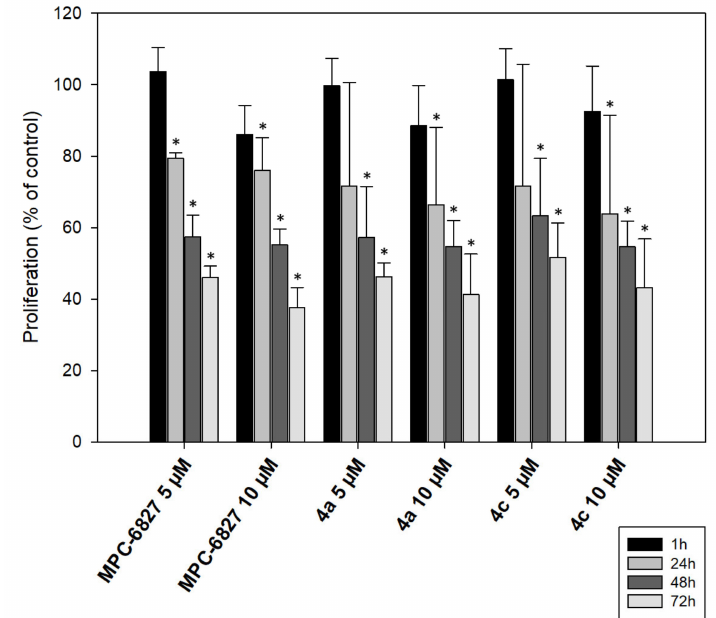
Figure 4. Proliferation of HT-29 cells treated with MPC-6827 (5 and 10 µ M), 4a (5 and 10 µ M) and 4c (5 and 10 µ M) after 1, 24, 48 and 72 h of treatment. Proliferation was evaluated with an MTT assay. Data are reported as the mean ± SD in percentage from three independent experiments. * P < 0.05 vs. control that represented 100% of